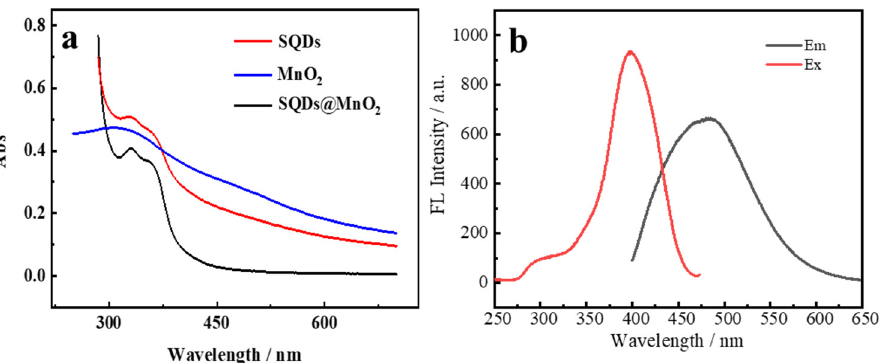
Figure 4. ( a ) UV-Vis spectra of SQDs, MnO 2 NS, and SQDs@MnO 2 NS; ( b ) the excitation and emis- sion spectra of SQDs@MnO 2 .